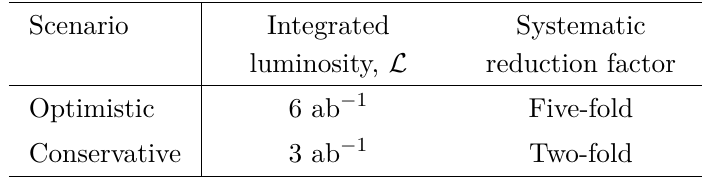
Table 2 . A comparison between the two scenarios used in this paper to produce HL-LHC pseu- dodata. In the optimistic scenario, the total integrated luminosity is assumed to be 6 ab − 1 from the combination of the ATLAS and CMS measurements; additionally, a five-fold reduction in sys- tematic errors is assumed. In the conservative scenario, the total integrated luminosity is assumed to be 3 ab − 1 (assuming only a measurement from ATLAS or CMS is available); additionally, a two-fold reduction is systematics is